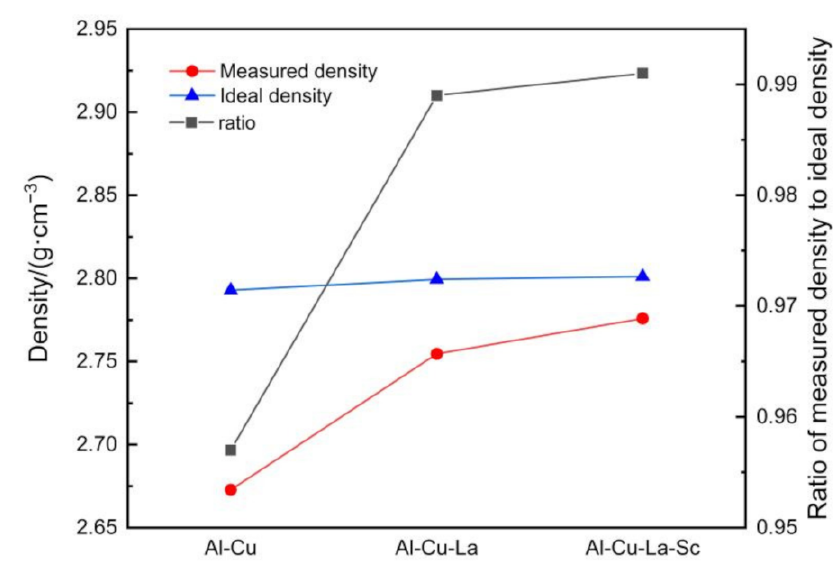
Figure 9. The ratio of measured density to ideal density of Al-Cu, Al-Cu-La, Al-Cu-La-Sc alloys.